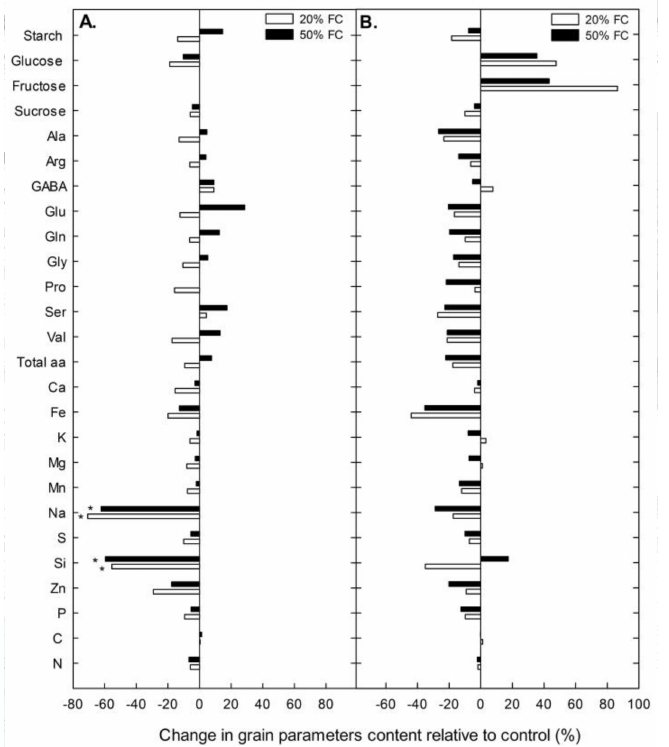
Figure 1. Change in grain quality parameters relative to control (%) in the Rainbow ( A ) and Illpa ( B ) cultivars grown under an irrigation regime of 100% substrate holding full capacity (FC), 50% FC and 20% FC. The asterisks indicate significant di ff erences with p < 0.05 of the treatment relative to control ( n =